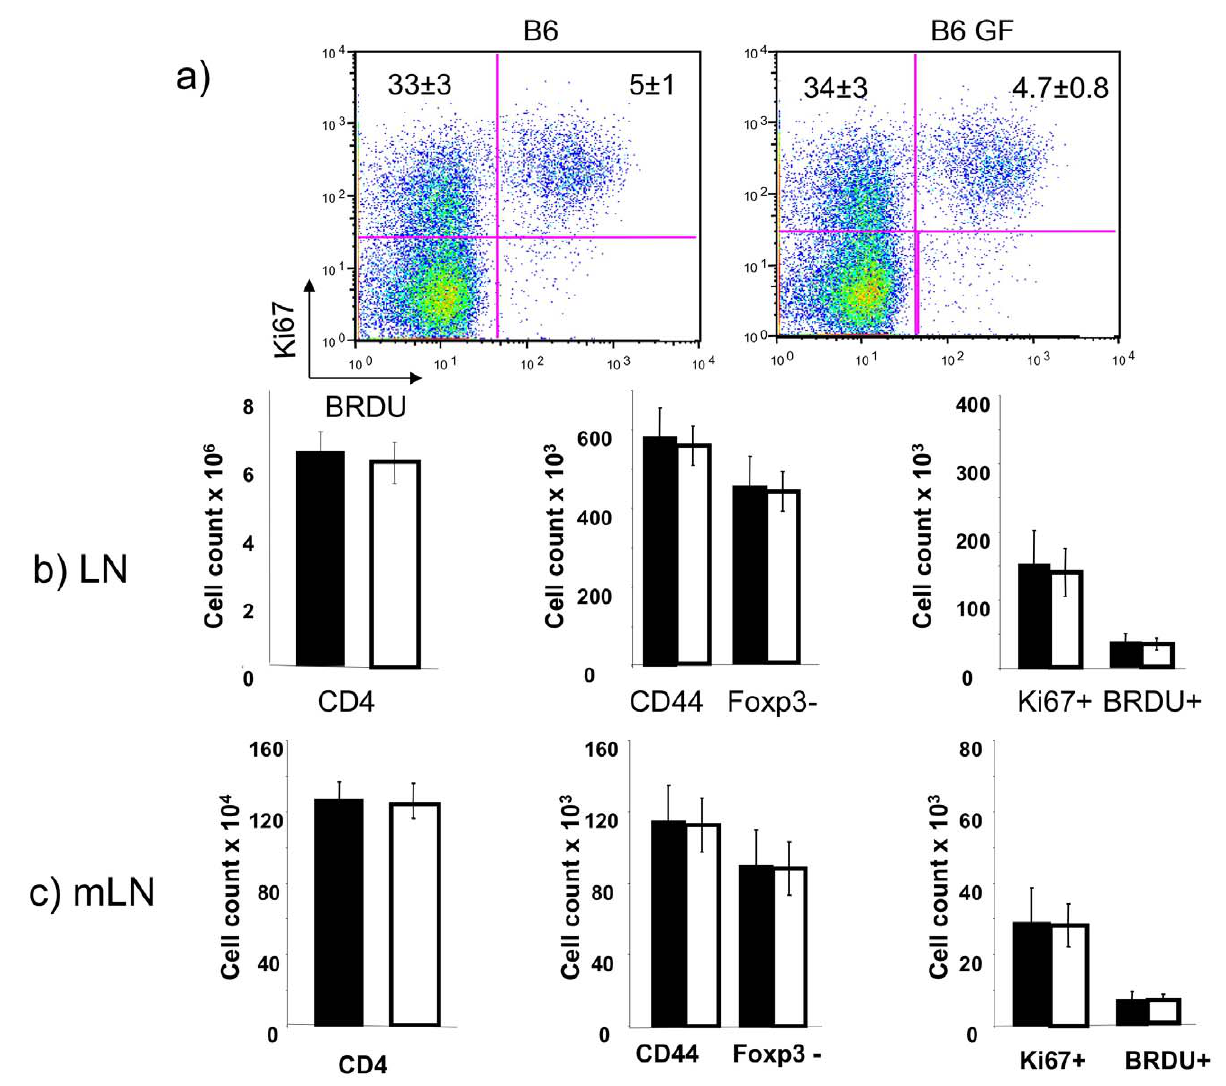
Figure 2. In situ proliferation of MP cells in GF mice. (A) Conventional B6 and B6 GF mice received an IP injection of 1 mg BrdU and were humanely killed 6 h later. Lymph nodes cells were collected and stained with anti-Foxp3, anti-CD4, anti-CD44, anti-BrdU, and anti-Ki-67. The numbers in the upper quadrants represent the mean percent of BrdU + and Ki-67 + cells (mean 6 SD for three replicate animals). (B and C) Numbers of CD4 + , CD44 + , CD44 + Foxp3 2 , Ki-67 + , and BrdU + cells in peripheral LN (B) and mesenteric LN (C) of conventional (black bars) and GF (white bars)